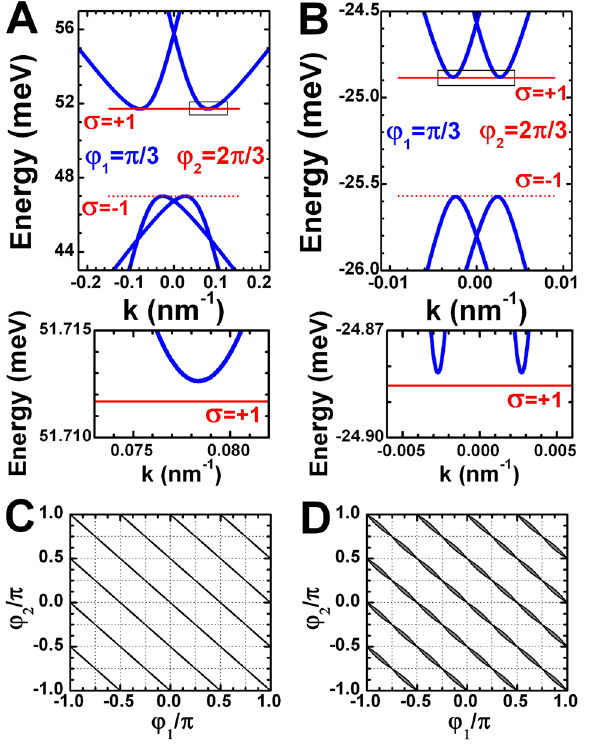
Figure 4. Topological corner states in (001)-oriented prototype QWs. ( A , B ) 1D dispersion of the edge states δ E 0D (in red) formed by the π/ 3 and the corner states energy E 0D (in blue) for the boundary oriented at ϕ 1 + = 2 π/ 3 . The ( A ) and ( B ) correspond to the (001) three-layer InAs/GaInSb ( A ) second boundary oriented at ϕ 2 = and double HgTe/CdHgTe QWs, respectively. The layer thicknesses of the QWs are marked by the red symbols in Fig. 1B,C. ( C , D ) The phase diagram for the presence (grey region) and absence (white region) of topological corner states in the three-layer InAs/GaInSb and double HgTe/CdHgTe QWs as a function of the two edge 0 is fulfilled. The vertical and β 2 orientations. In the grey regions, the existence condition of Eq. (26) at β 1 = = horizontal thin dotted lines represent the angles when the edges of 2D system, which are actually the faces of 1 10 (001)-oriented QWs, coincide with [110], , [100] and [010] crystallographic ¯ [ ]